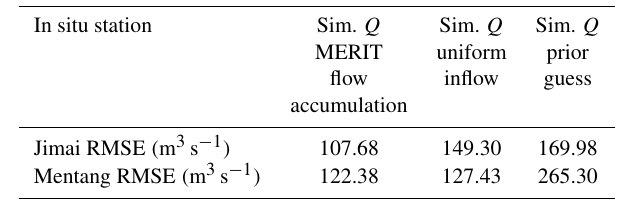
Table 2. RMSE between in situ discharges measured at Jimai and Mentang stations and the estimated discharge. Three different cases are presented, using the MERIT flow accumulation map, uniform inflow, and the estimations with the prior